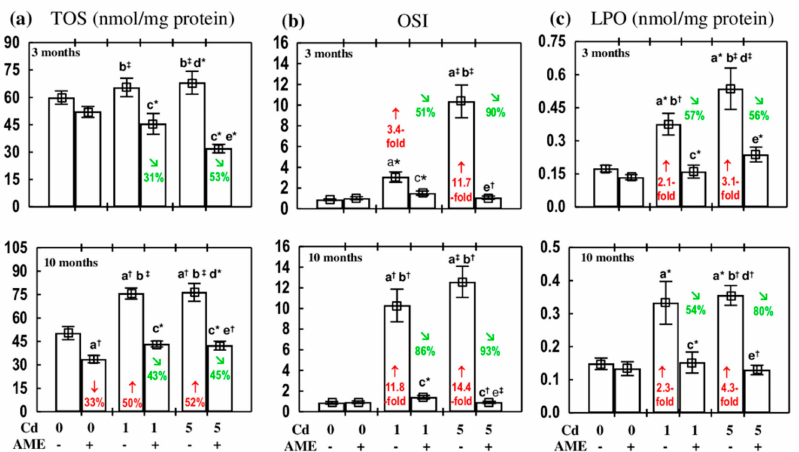
Figure 2. The e ff ect of the extract from Aronia melanocarpa L. berries (AME) on the markers of oxidative status of the submandibular gland of female rats exposed to cadmium (Cd). ( a ) total oxidative status (TOS); ( b ) oxidative stress index (OSI); ( c ) lipid peroxides (LPO) concentration. The animals received cadmium in the diet at concentrations of 0, 1, and 5 mg Cd / kg and / or 0.1% aqueous AME ( + ) or not ( − ). Data are presented as mean ± SE for eight rats. Statistically significant di ff erences (Kruskal–Wallis post hoc test): a compared to the control group, b compared to the AME group, c compared to the Cd 1 group, d compared to the Cd 1 + AME group, e compared to the Cd 5 group, where * p < 0.05, † p < 0.01, and ‡ p < 0.001. Numerical values in bars or above the bars reveal the percentage changes or factors of changes in comparison to the respective control group ( ↓ , decrease; ↑ , increase;) or the appropriate group that received cadmium alone ( (cid:38) ,